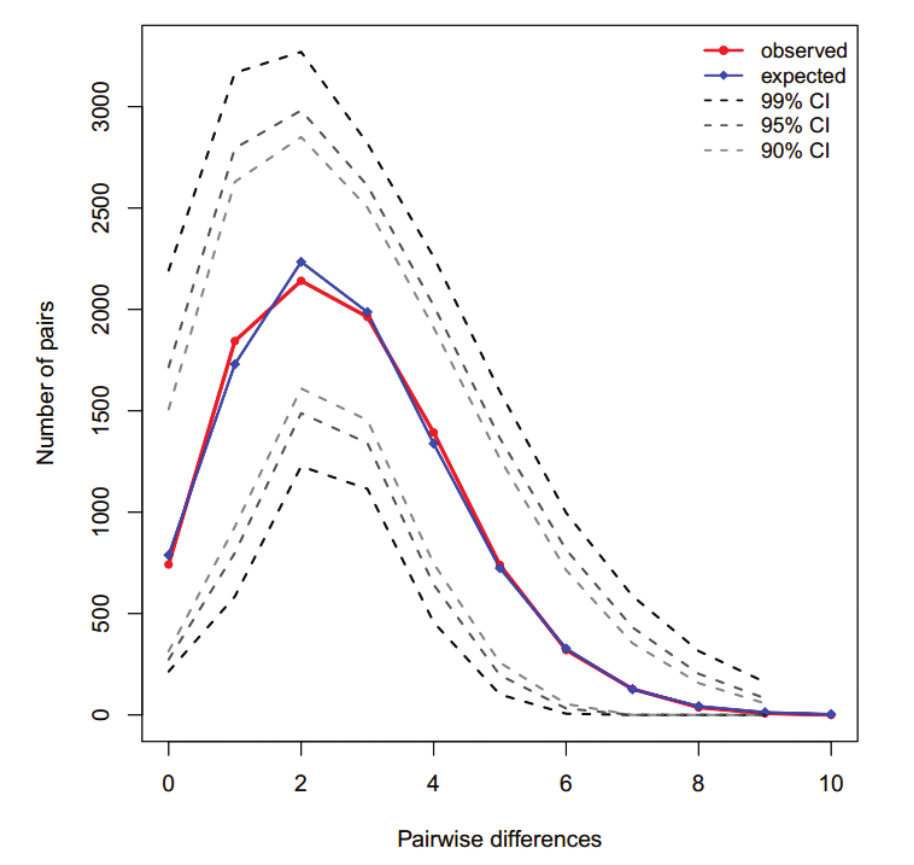
Figure 4. Observed and expected mismatch distribution under the sudden expansions model of the control region haplotypes in J. grypotus